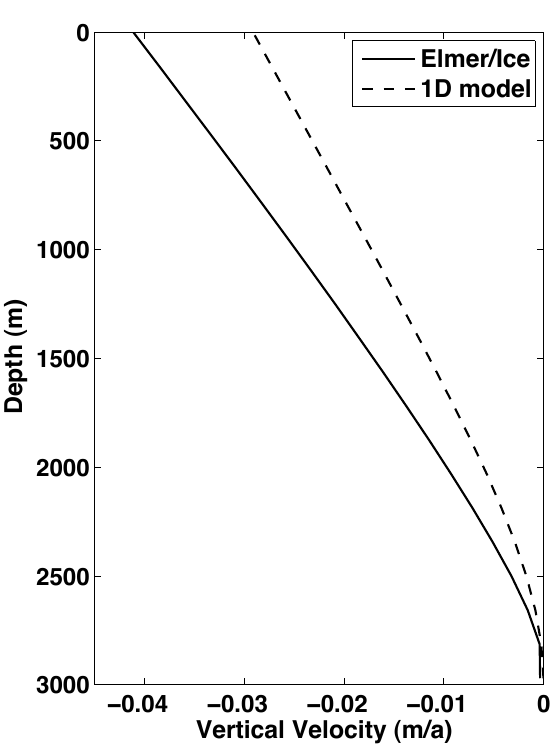
Fig. 12. Anisotropic steady-state simulation: profile of the vertical velocity at the Dome Fuji drill site (solid line). The dashed line shows the vertical velocity produced with a one-dimensional flow model constrained by age markers (Parrenin et al., 2007b).